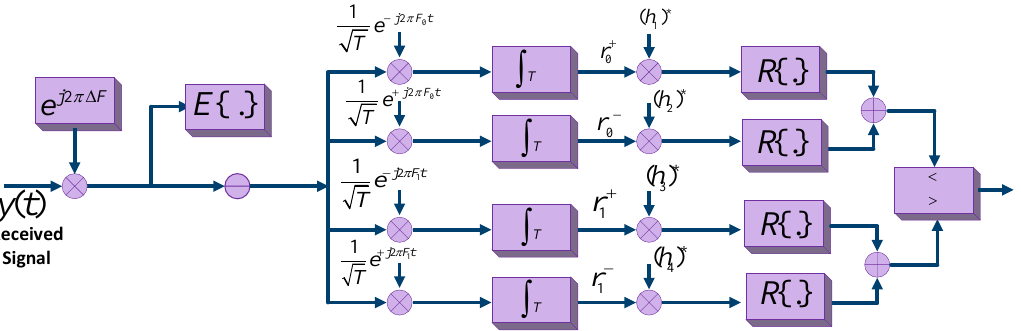
Figure 16. The Structure of Coherent Correlation Receiver with Four Correlators and Two Pairs of Complex Channel